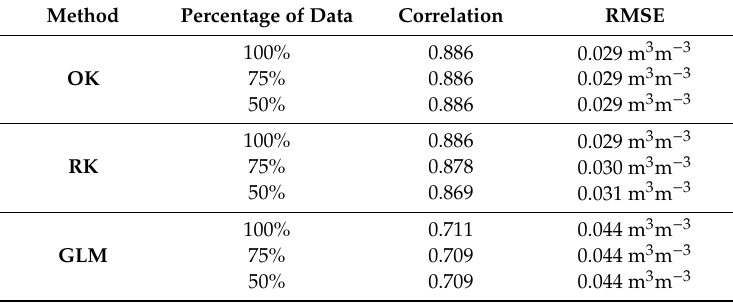
Table 2. Cross-validation outputs for OK, RK, and GLM, and all predicted and observed values along the 153 monthly layers.